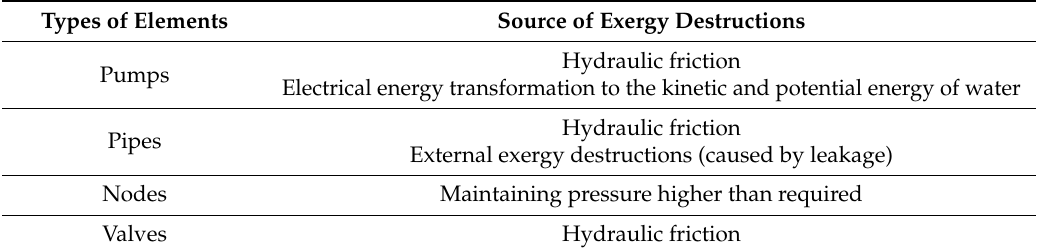
Table 1. Source of exergy destructions in a water distribution system.